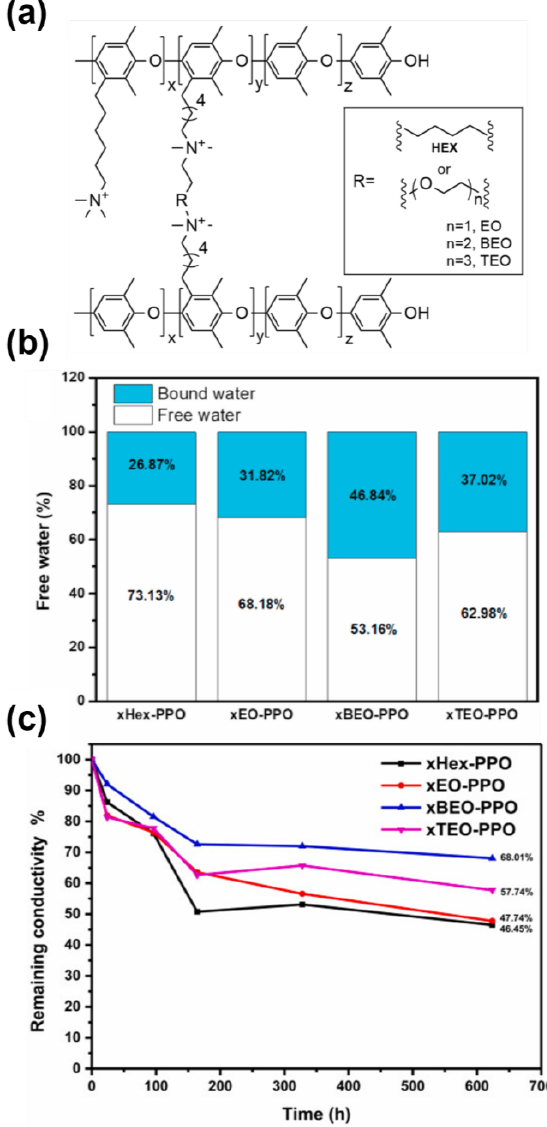
Figure 5. ( a ) Structure of the crosslinked PPO membranes with hexyl- and O-containing crosslinkers. ( b ) The relative fractions of free water and bound water. ( c ) Remaining hydroxide conductivity after the alkaline stability tests in a 1 M KOH solution at 80 °C. Adapted with permission from Ref. [86]. Copyright 2021 Elsevier.